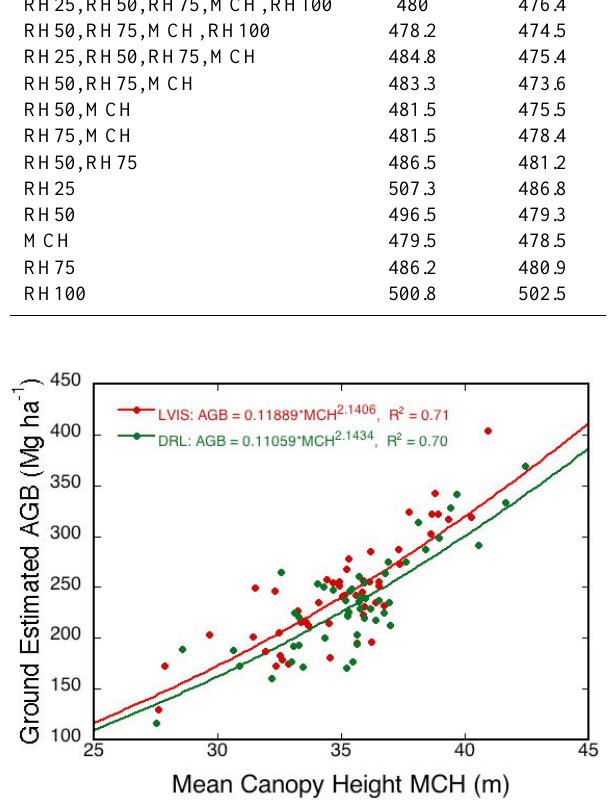
Fig. 2. Relationship between ground-estimated AGB and MCH from LVIS and DRL, at 1ha. The coefficients of the two equations are very